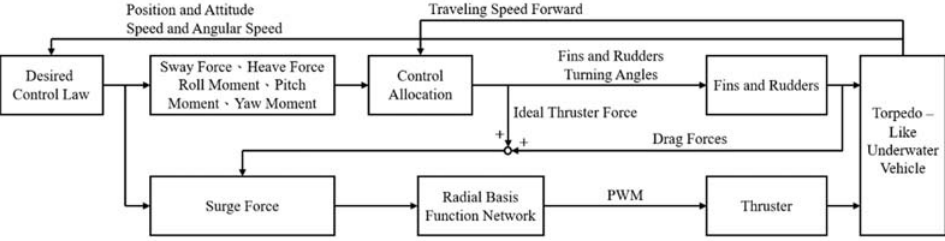
Figure 2. The flow chart of the control allocation procedure for the torpedo-like underwater vehicle with multiple actuators.